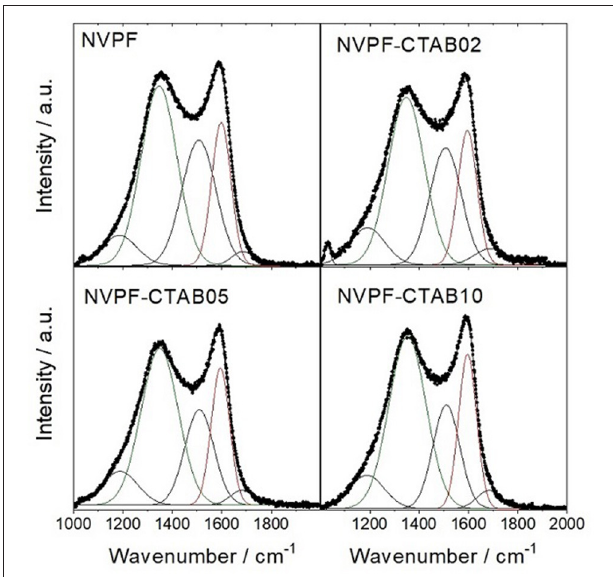
FIGURE 4 | Raman spectrum of C@Na 3 V 2 (PO 4 ) 2 F 3 recorded with λ 0 = 532nm. The band assignment has been indicated.